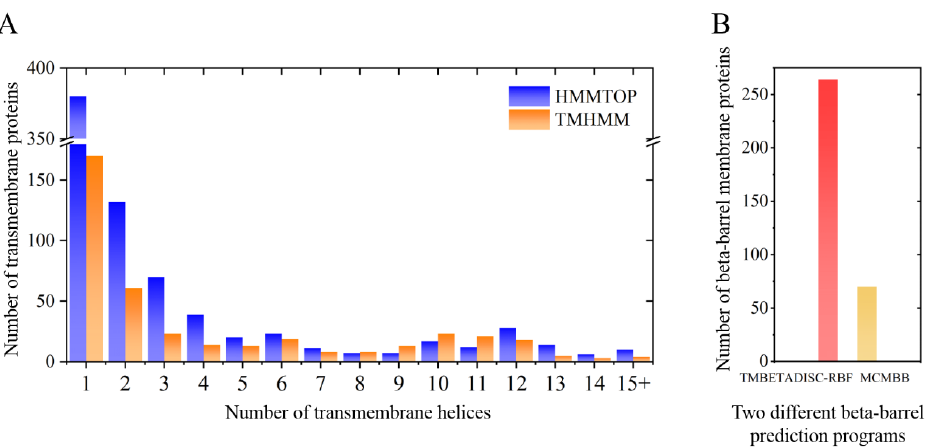
Figure 3. Number of transmembrane domains predicted in the M. crystallinum membrane proteome. ( A ) Transmembrane helix prediction by HMMTOP and TMHMM, and ( B ) beta-barrel predictions by TMBETADISC-RBF and MSMBB transmembrane prediction data are summarized in Table S1.